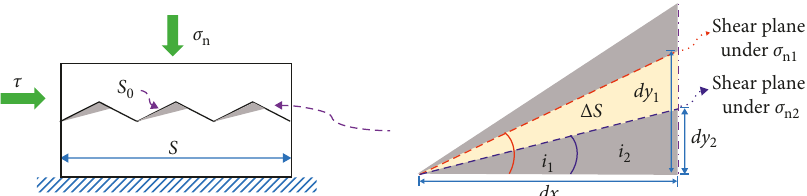
are normal n is a low n1 , and Δ S denotes 2